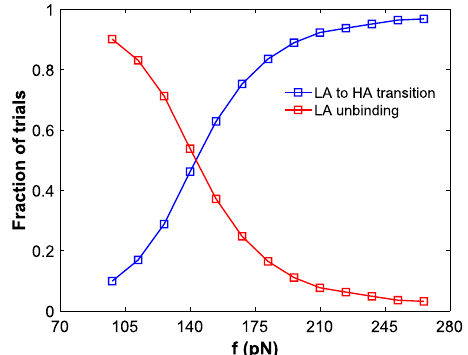
Fig. 2 Force dependence of the fraction of trials for the dimer to dissociate in the LA state and dimer to transition from the LA to the HA state. LA unbinding is shown in red and LA-to-HA transition is shown in blue.